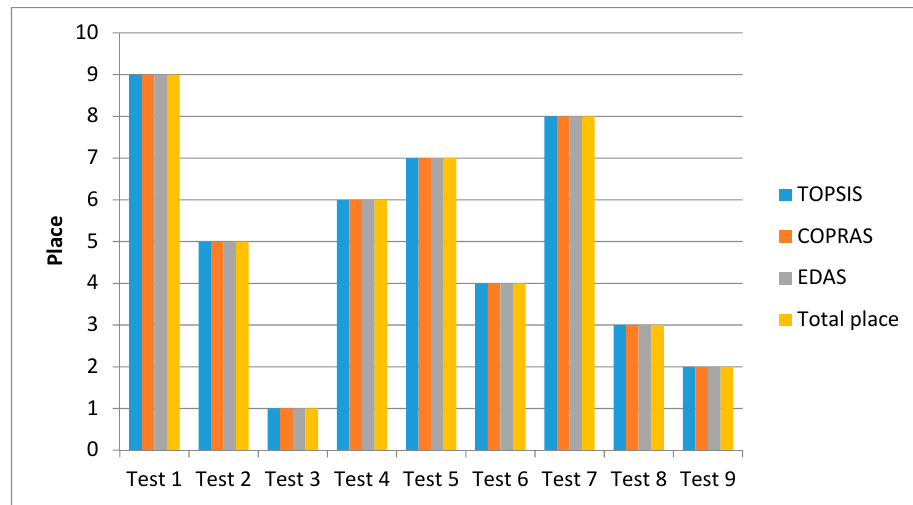
Figure 8. Results of the MCDM evaluation for TOPSIS, COPRAS and EDAS methods for a 110 Hz vibration frequency.